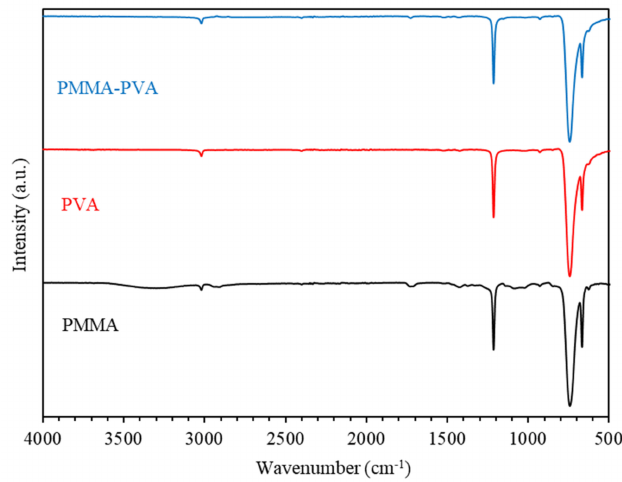
Figure 15. FTIR spectra of PMMA–PVA polymeric thin films as a function of wavenumber.